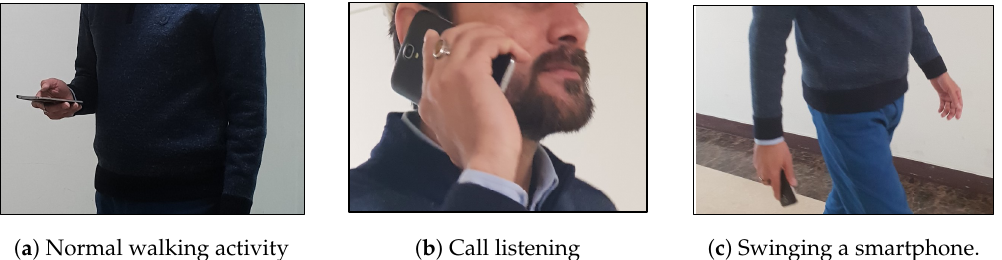
Figure 7. Types of user activities on a smartphone of the proposed